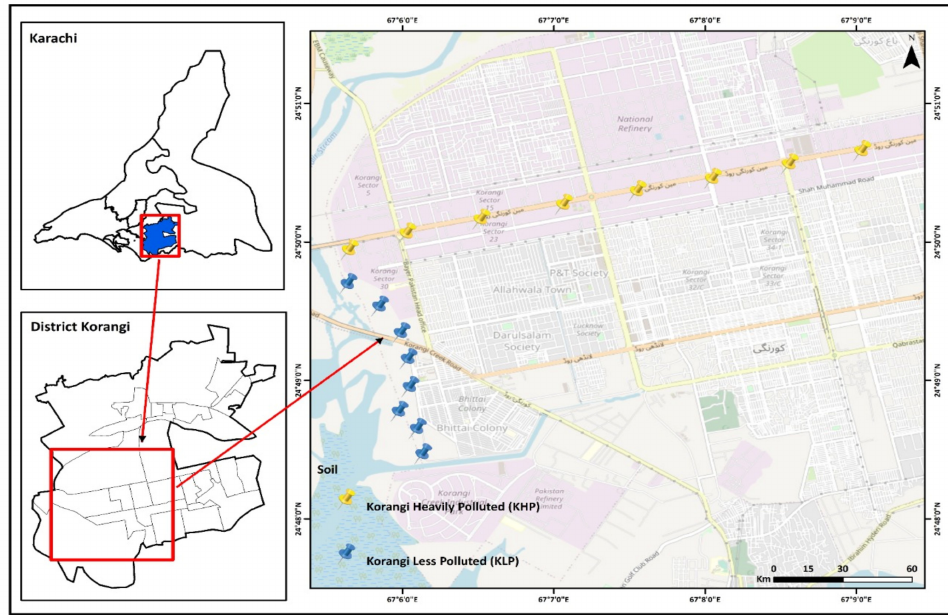
Figure 1. Map location of study